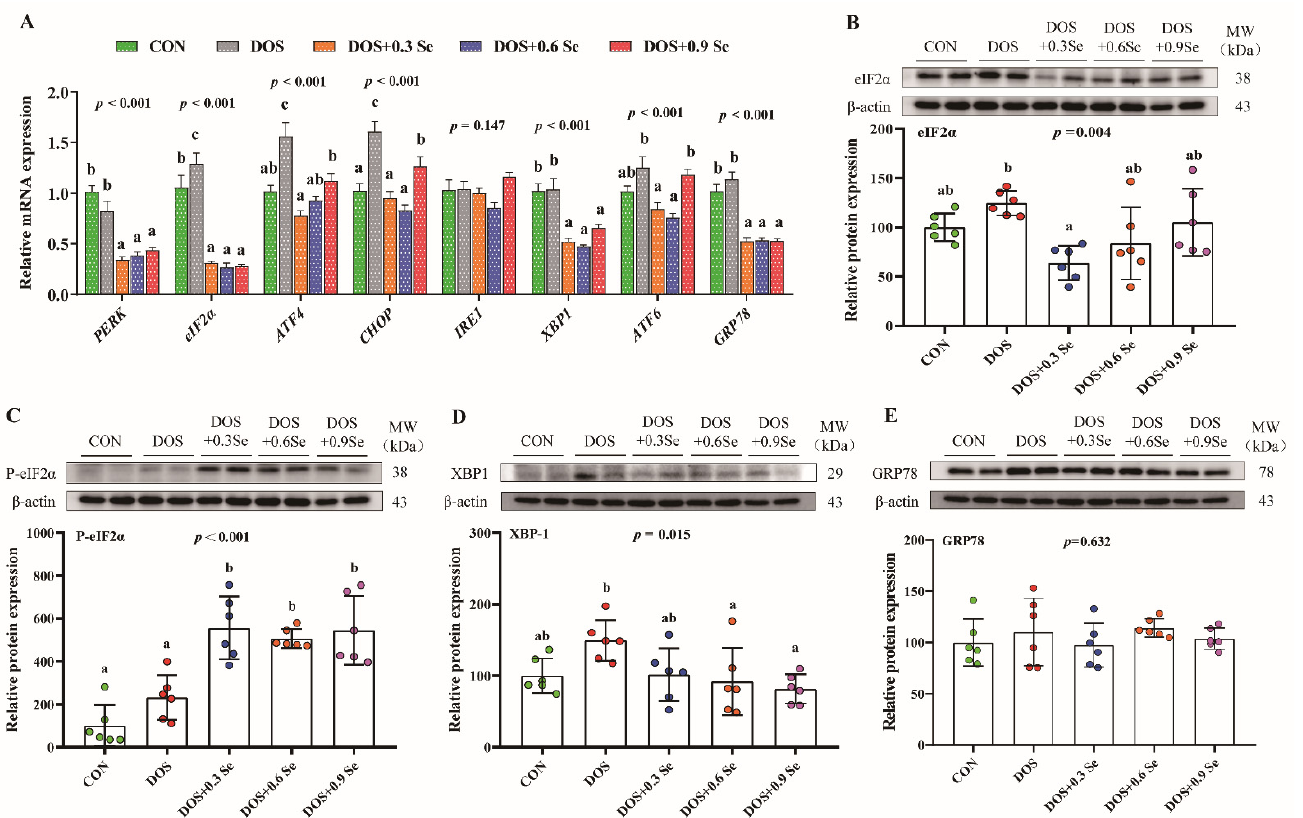
Figure 3. Effects of dietary oxidative stress and OH-SeMet supplementation on the ER stress biomarkers in the liver of growing-finishing pigs. ( A ) The mRNA abundance of PERK , eIF2 α , ATF4 , CHOP , IRE1 , XBP1 , ATF6 and GRP78 ; ( B ) Relative protein abundance of eIF2 α ; ( C ) Relative protein abundance of P-eIF2 α ; ( D ) Relative protein abundance of XBP1; ( E ) Relative protein abundance of GRP78. Results were expressed as mean ± SD ( n = 6), different letters indicate ANOVA p value less than 0.05 which represent there is a significant difference between groups.